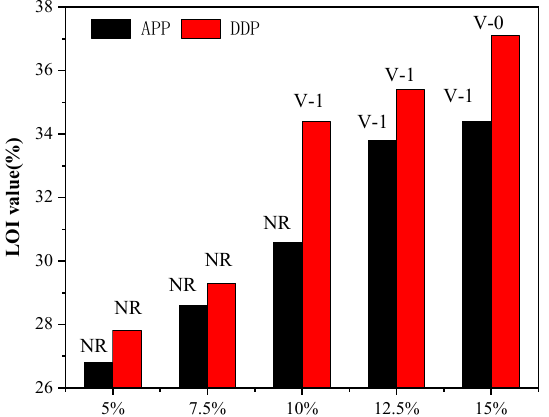
Figure 8. LOI value and UL94 rating of neat EP and EP blends.